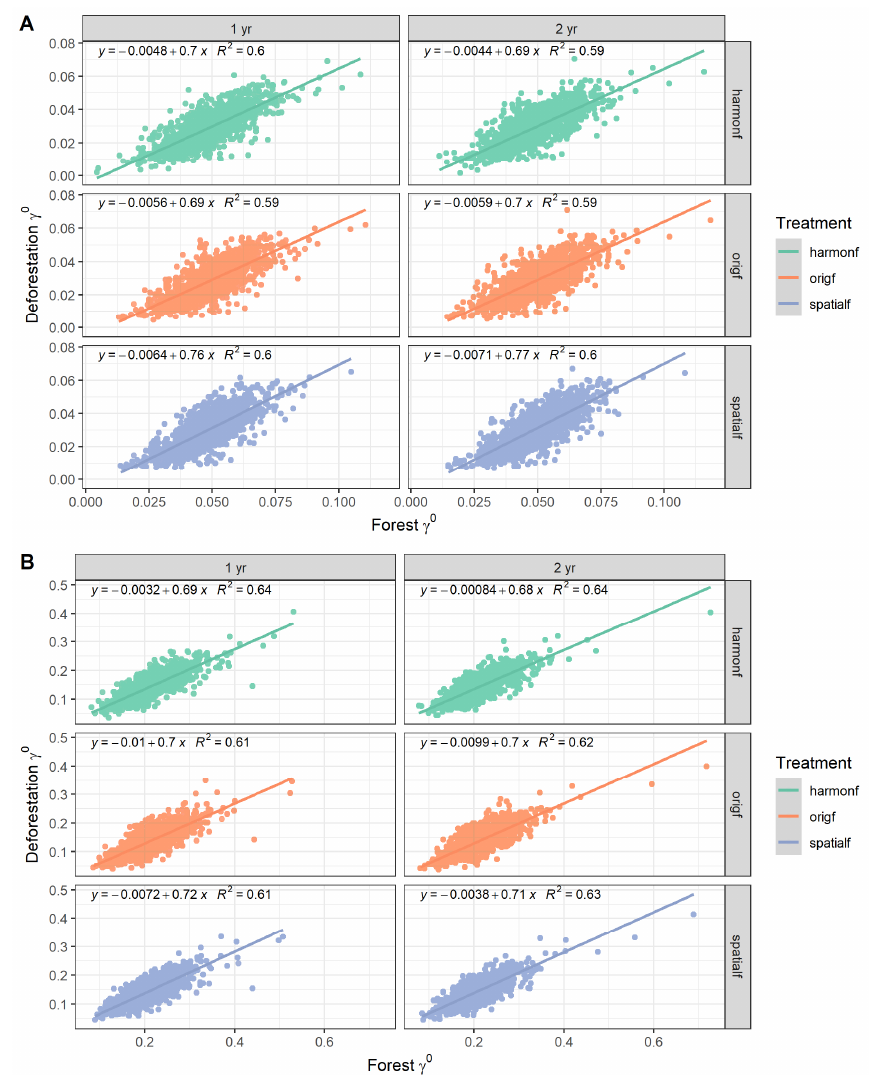
Figure 7. Correlation between the forest and deforested means for VH ( A ) and VV polarizations ( B ).